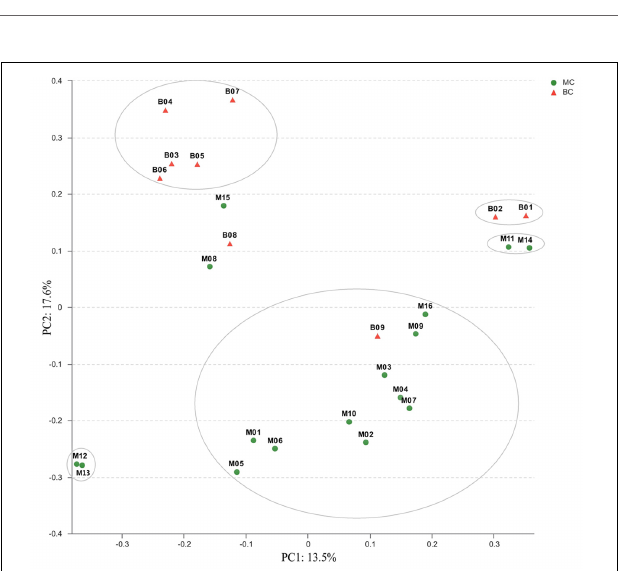
FIGURE 3 | Principal co-ordinates analysis (PCoA) plot based on the OTU level from 25 coral species. The scatter plot is of principal coordinate 1 (PC1) vs. principal coordinate 2 (PC2). PC1 and PC2 represent the principal factors affecting bacterial composition associated with corals.